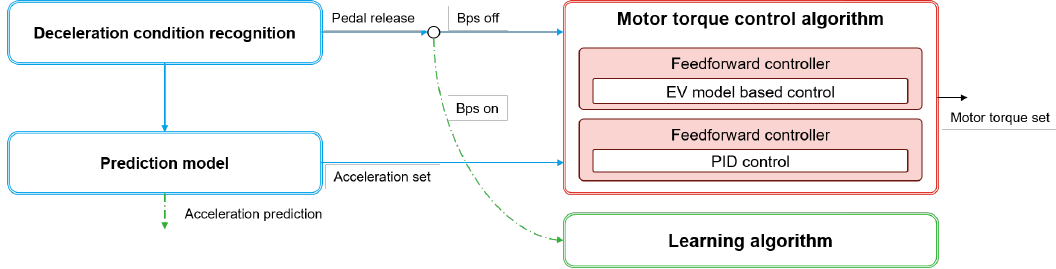
Figure 24. Learning results for model parameters on the dynamic deceleration condition.